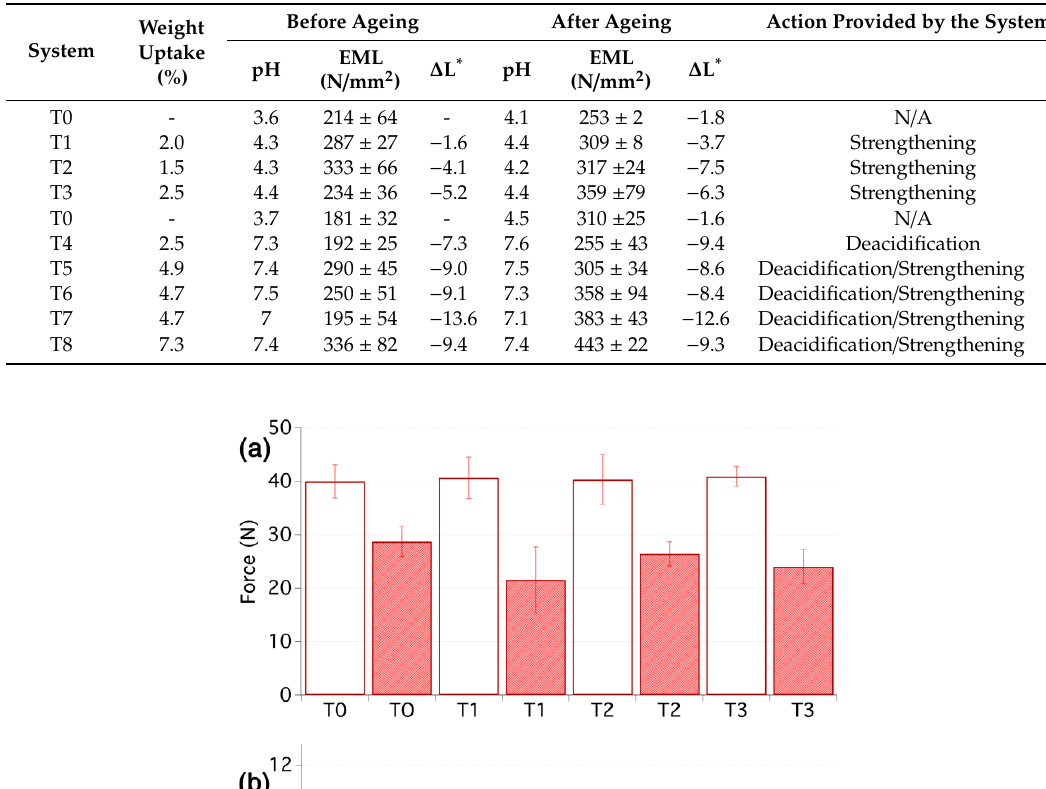
Table 1. E ff ect of the di ff erent treatments before and after the artificial ageing on pH, elastic modulus at low deformation (EML) and colour change in terms of lightness change ( ∆ L * ). Weight uptakes are also reported.